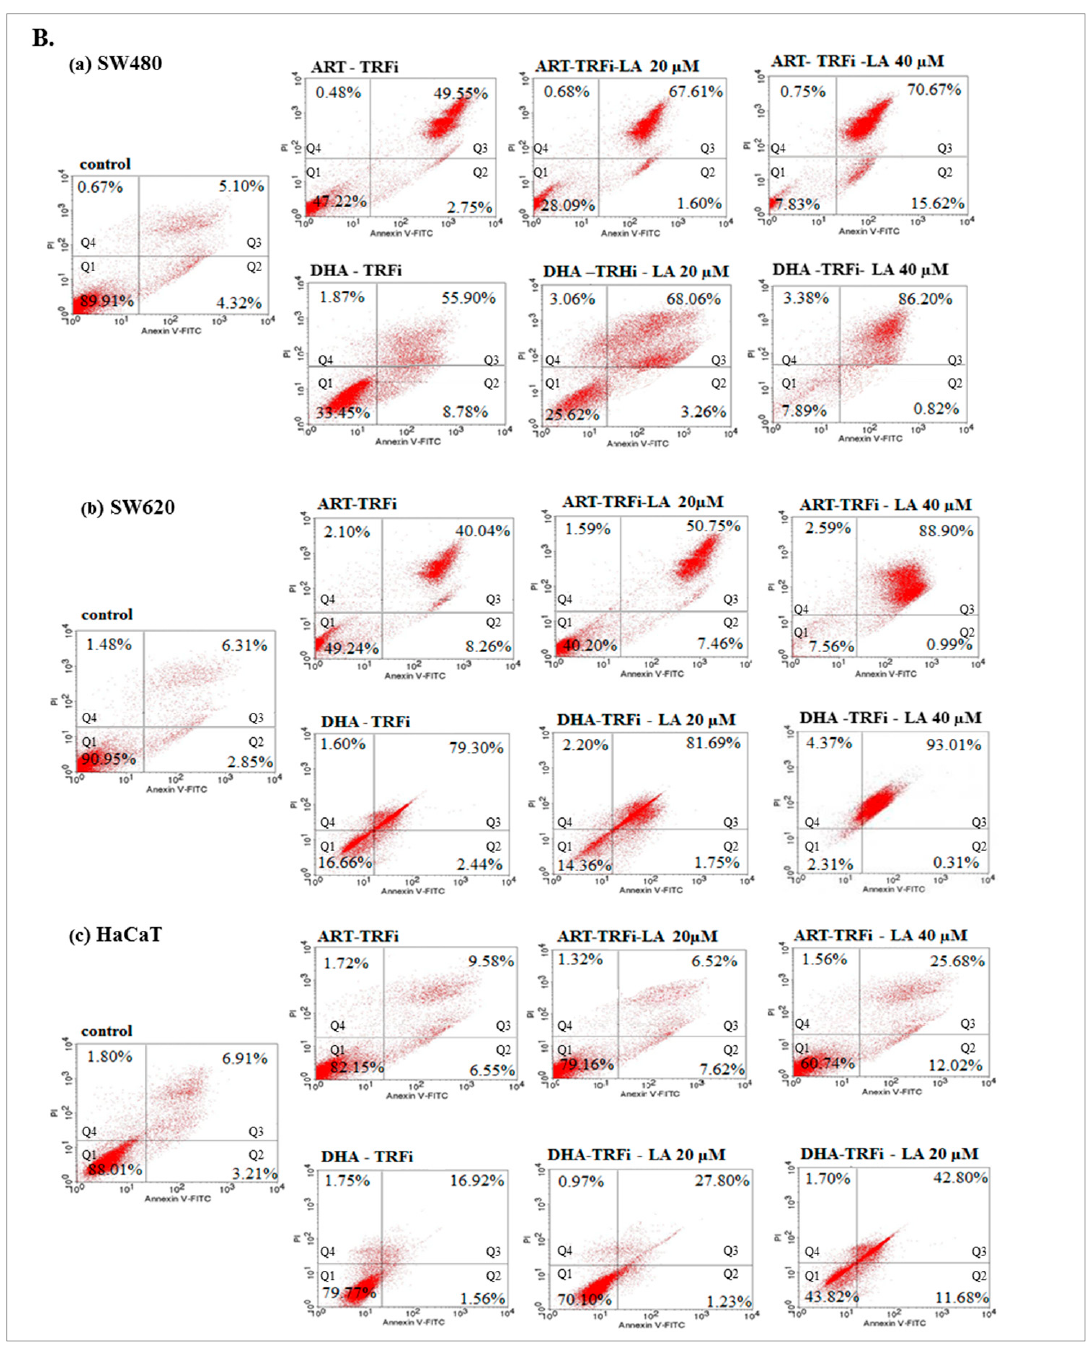
Figure 4. The effect of ART, DHA, and LA ( A ), ART and DHA with TRFi and LA ( B ) on late apoptosis in SW480 ( a ), SW620 ( b ), and HaCaT ( c ) cells detected with Annexin V-FITC/PI by flow cytometry. Diagrams show representative experiments. A total of 10,000 events were collected. The lower left quadrant (Q1) represent viable cells and the lower right quadrant (Q2) early apoptotic cells. The upper right quadrant (Q3) contains late stage apoptotic cells, and the upper left quadrant (Q4) necrotic cells.